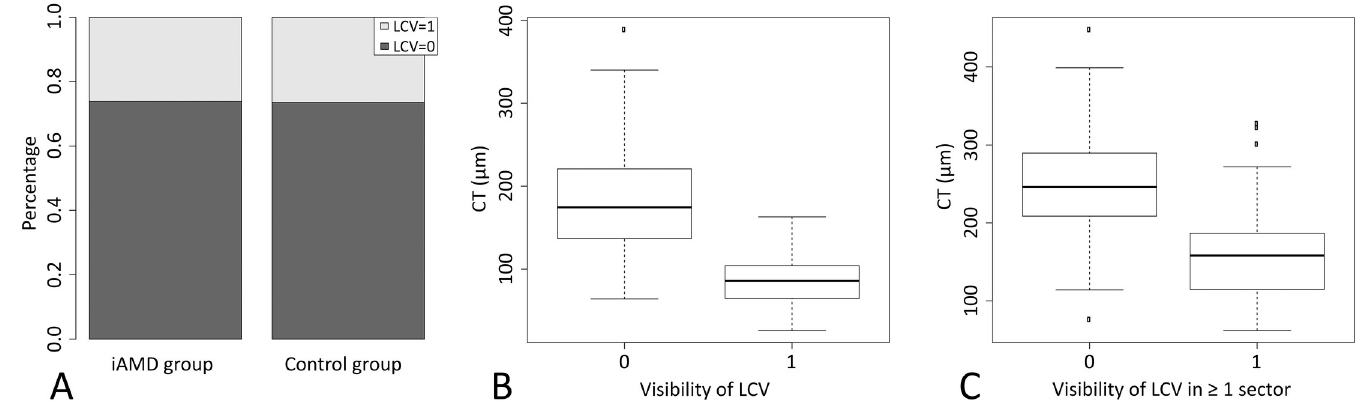
Fig 4. Visualization of the impact of group, choroidal thickness (CT) and central choroidal thickness (cCT) on the visibility of large choroidal vessels (LCV). (A) Barplots showing the proportions of sectors with visible LCV (shown in light gray) and without visible LCV (shown in dark gray) for the intermediate age-related macular degeneration (iAMD) and control group separately. (B) Boxplots showing the relationship between visibility of LCV and CT. (C) Boxplots showing the relationship between visibility of LCV in at least one sector and cCT.